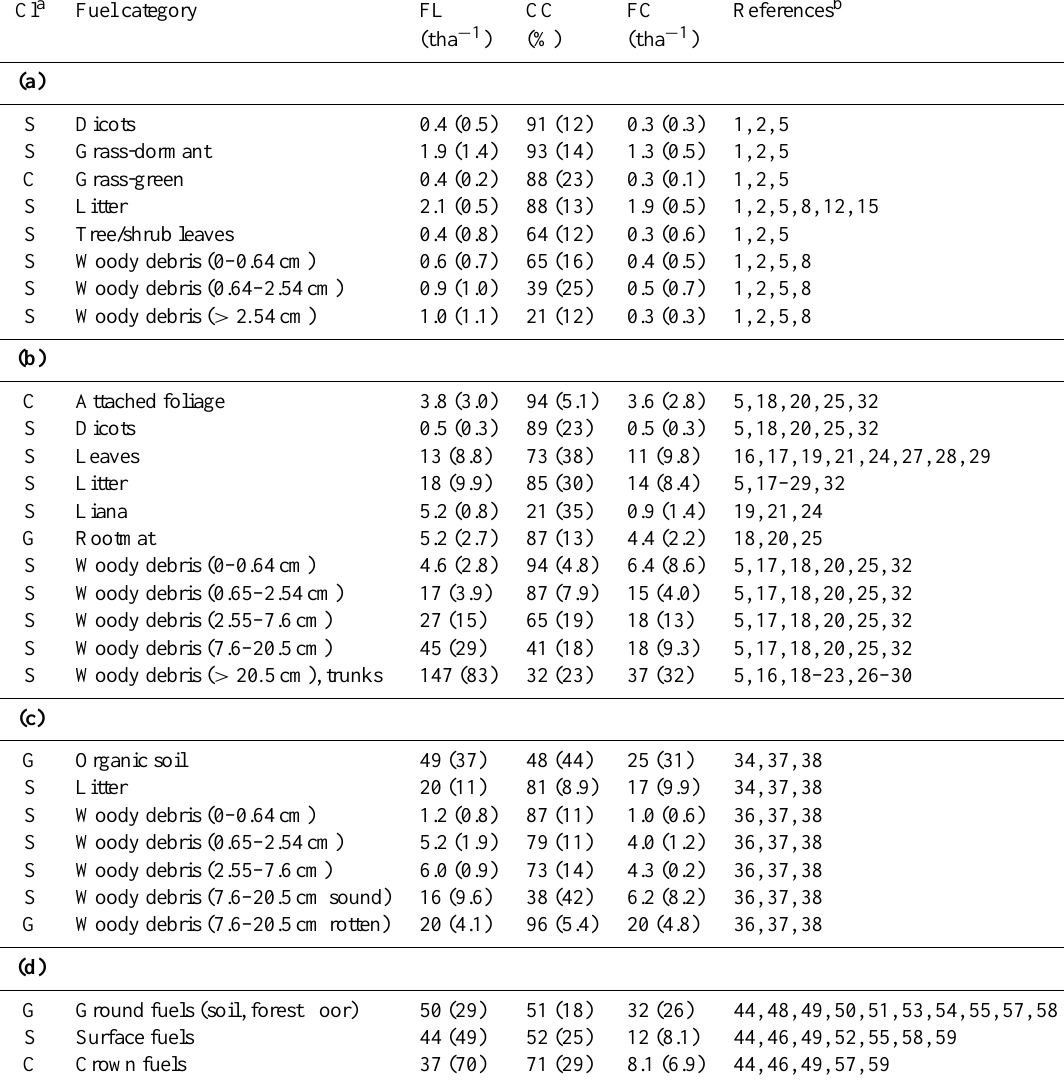
Table 2. Fuel load (FL), combustion completeness (CC) and fuel consumption (FC) field measurements for different fuel categories within the savanna (a) , tropical forest (b) , temperate forest (c) , and boreal forest (d) biomes. Standard deviation (SD) is shown in